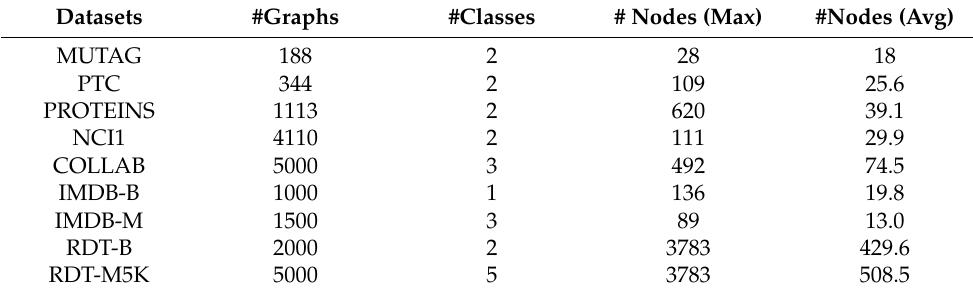
Table 2. Statistics of